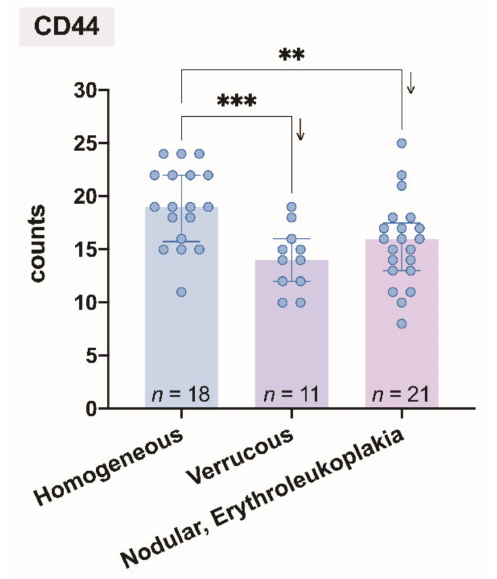
Figure 5. Comparison of the mean number of CD44 expressed in epithelial layers in leukoplakia tissue and clinical forms of oral leukoplakia. Levels of statistical significance: ** p < 0.01, *** p < 0.001 (Ordinary one-way ANOVA with two-stage linear step-up procedure of Benjamini, Krieger, and Yekutieli as a post hoc procedure). The arrows indicate a decrease in the average value of the corresponding